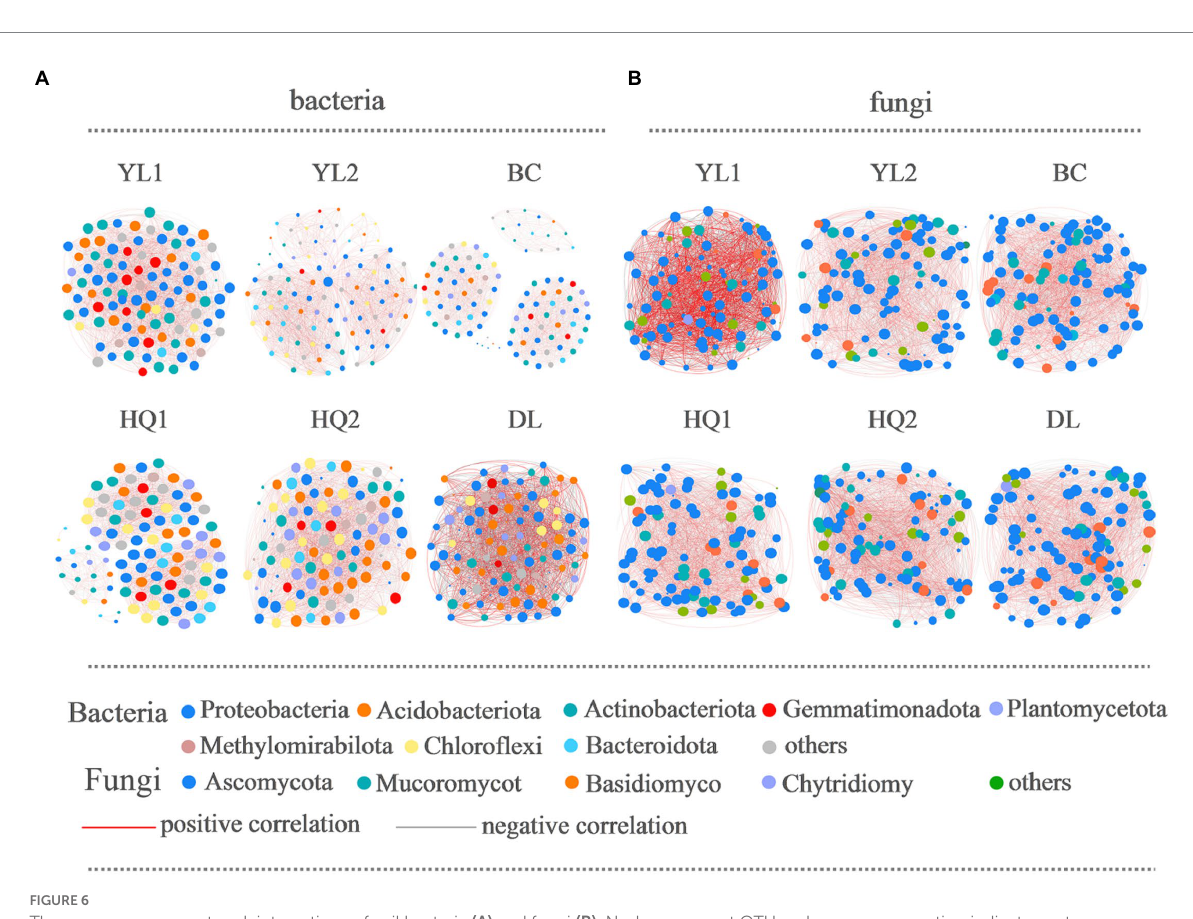
FIGURE 6 The co-occurrence network interactions of soil bacteria (A) and fungi (B) . Nodes represent OTUs, whereas a connection indicates a strong (Spearman’s |r| > 0.6) and significant positive ( p < 0.05) correlation. The color of the nodes indicated the phylum, the size of each node was proportional to the number of connections (i.e., degree); the thickness of each connection between two nodes (i.e., edge) was proportional to the Spearman’s correlation coefficient (red indicates a positive correlation and gray indicates negative